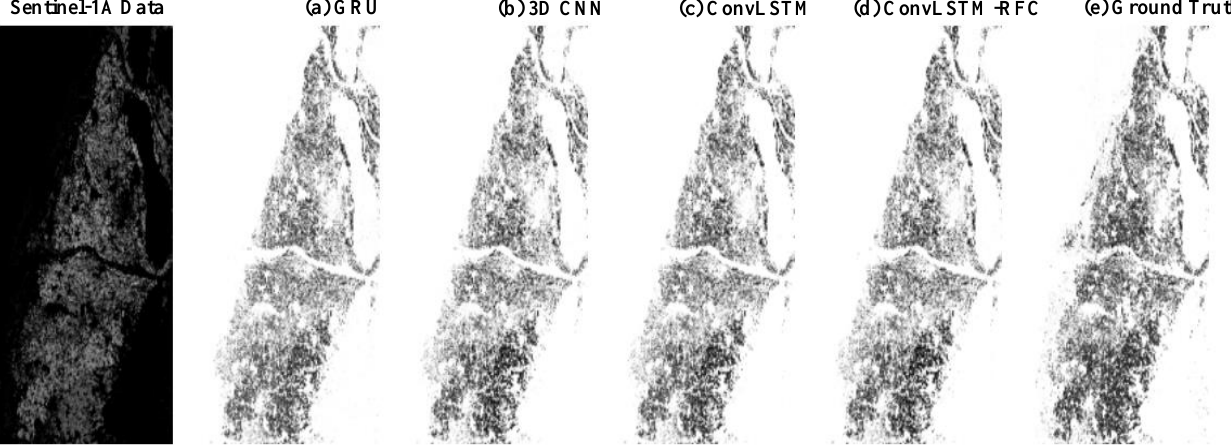
Figure 6. Sentinel-1A image and the rice field classification results of all the models. ( a ) Predicted result of GRU. ( b ) Predicted result of 3D CNN. ( c ) Predicted result of ConvLSTM. ( d ) Predicted result of ConvLSTM-RFC model. ( e ) Ground truth data from Agriculture and Food Agency